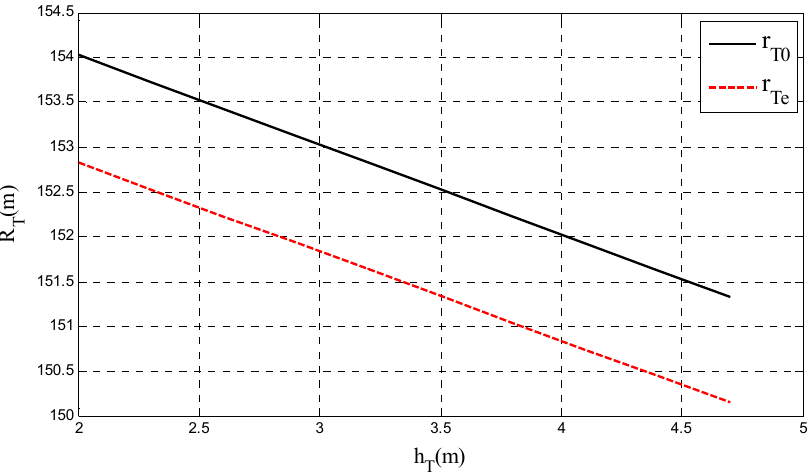
Figure 10. Equivalent radius of a frame structure equipped with SLDTFPB.